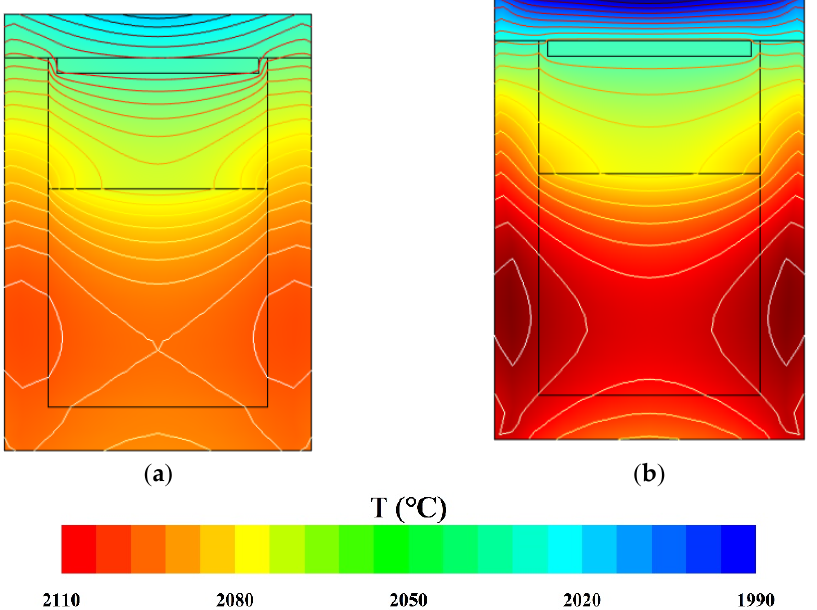
Figure 2. Distributions of temperature in ( a ) Graphite crucible and ( b ) TaC crucible.